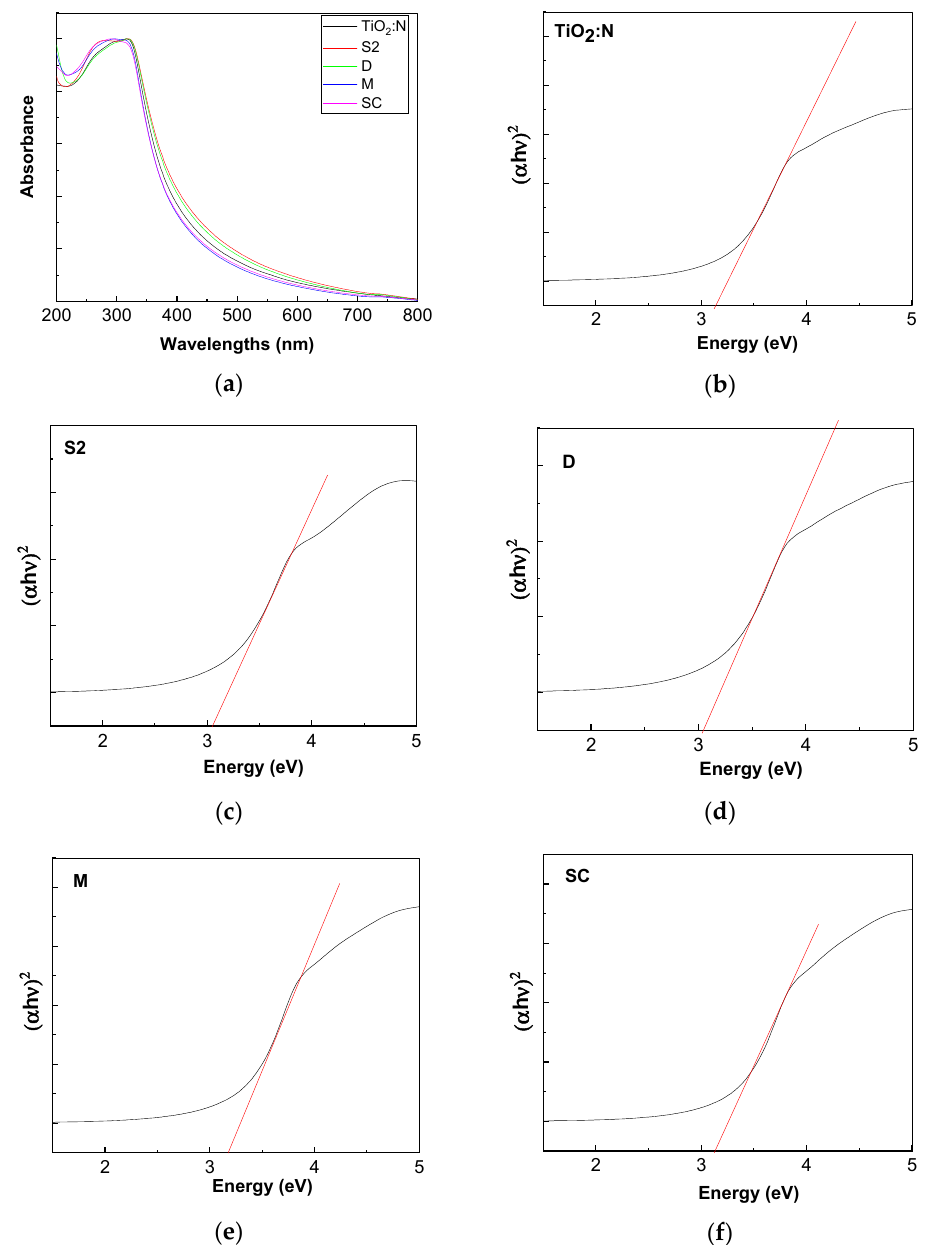
Figure 1. UV–VIS spectra ( a ) and the Tauc’s plots for the assessing of the band gap of the samples of TiO 2 :N ( b ), TiO 2 :N/SWNTs ( c ), TiO 2 :N/DWNTs ( d ), TiO 2 :N/MWNTs ( e ), and TiO 2 :N/SWNTs- COOH ( f ). The abbreviations M, SC, D and S2 correspond to samples with the composition shown in Table 1.